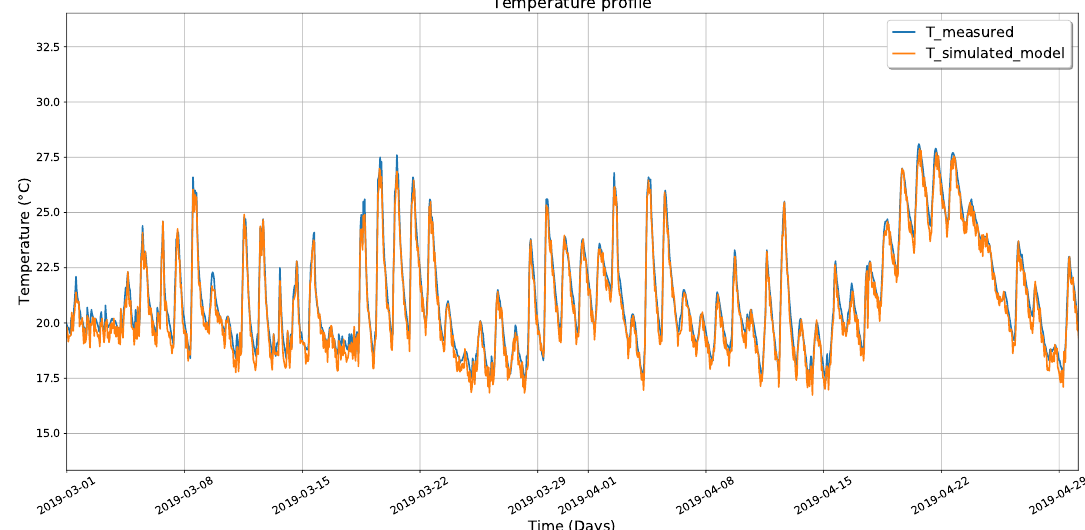
Figure 12. Validation of simplified thermal network model with measured zone temperature data (winter).